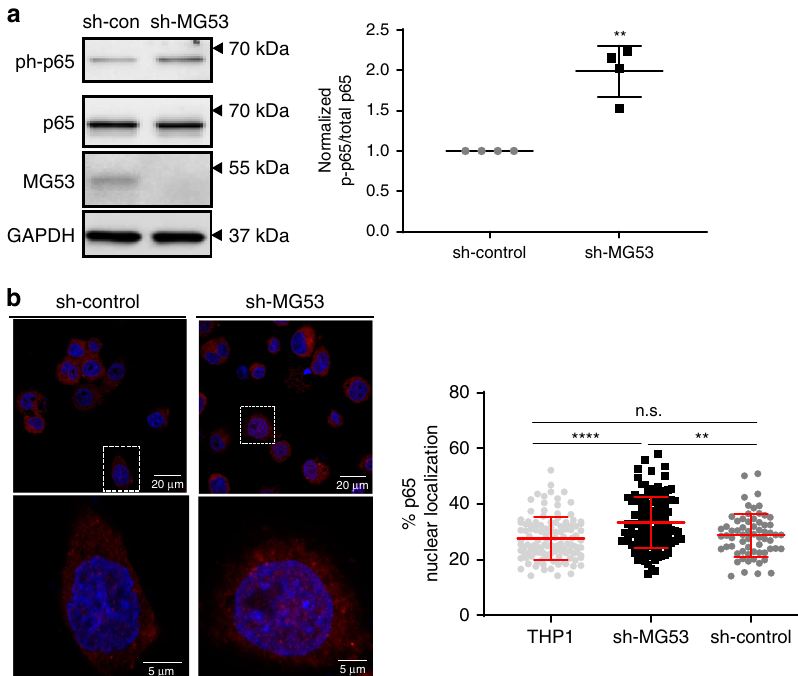
Fig. 4 MG53 modulates NF κ B activation and nuclear localization. a Protein lysates (10 µ g) from the indicated THP1 lines were loaded for western blot to assess p65 phosphorylation. Western blotting showed a ~2-fold increase in basal p65 phosphorylation in shMG53-THP1 cells compared with sh-control ( n of four independent experiments; mean ± SE; ** p = 0.0083; two-sided paired t test). b Cellular localization of p65 was assessed by immuno fl uorescence using p65 antibody. Nuclear localization of p65 is signi fi cantly increased in sh-MG53 THP1 cells compared to sh-control ( n = 119 THP1, 119 sh-MG53, and 65 sh-control cells examined over two independent experiments; mean ± SD; n.s. means nonsigni fi cant p = 0.6300, ** p = 0.0013, **** p < 0.0001; one-way ANOVA with Tukey ’ s multiple comparison